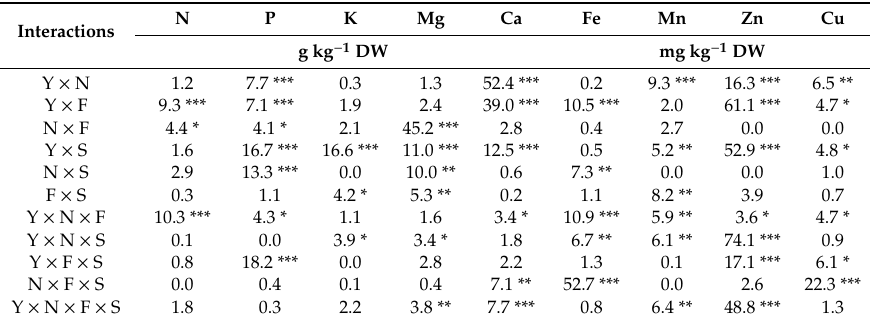
Table A5. Analysis of variance for interactions of factors in potato stems.